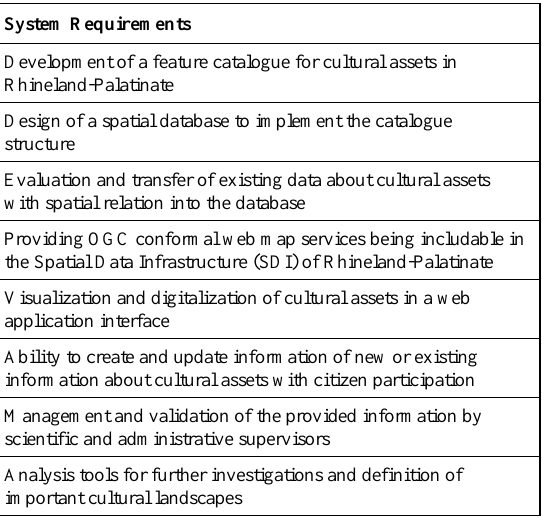
Table 2. Functional feature categories.